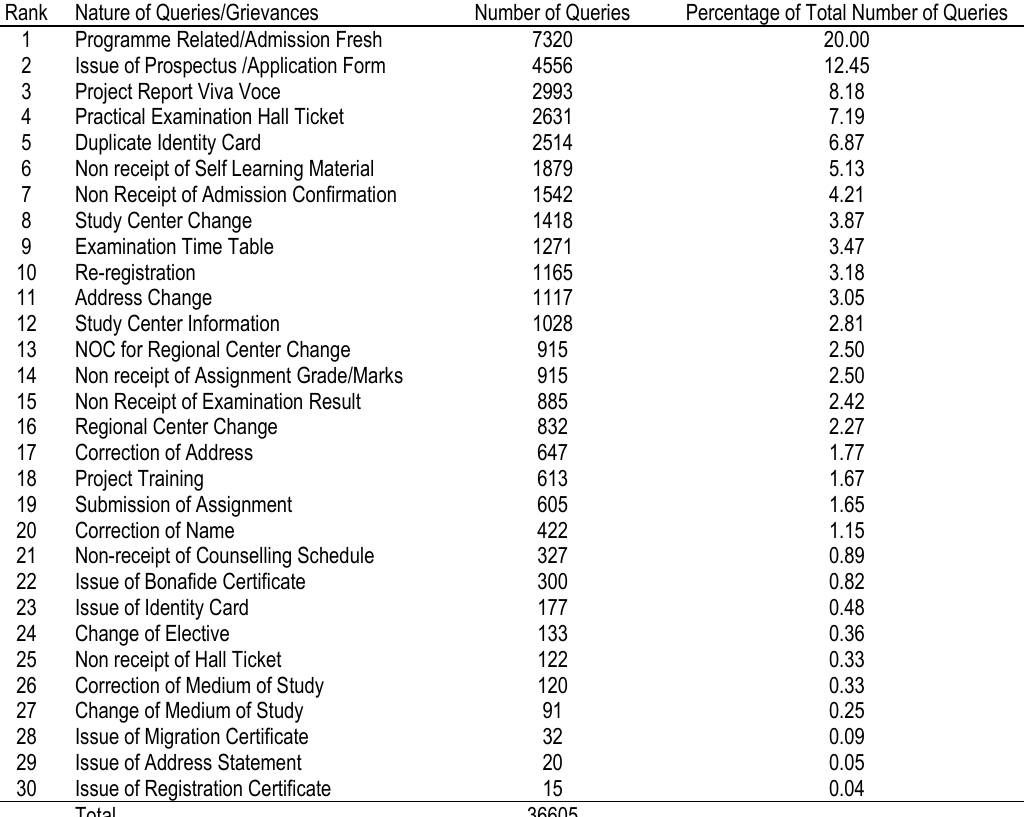
Table 5. Nature and Volume of Queries Received at Regional